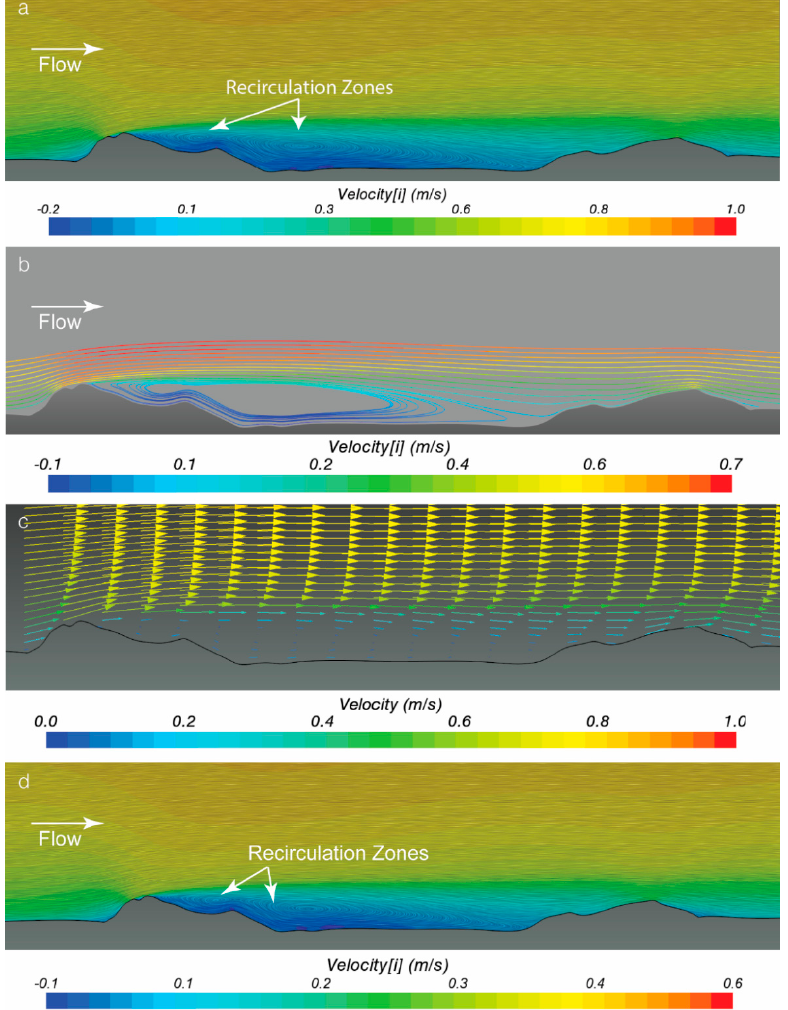
Figure 8. ( a ) Mean streamwise velocity distribution of ridge section one; ( b ) Streamline visualization of the ridge section one; ( c ) Velocity vectors of ridge section one; ( d ) Mean streamwise velocity distribution of ridge section one with 50% reduction in inlet velocity.